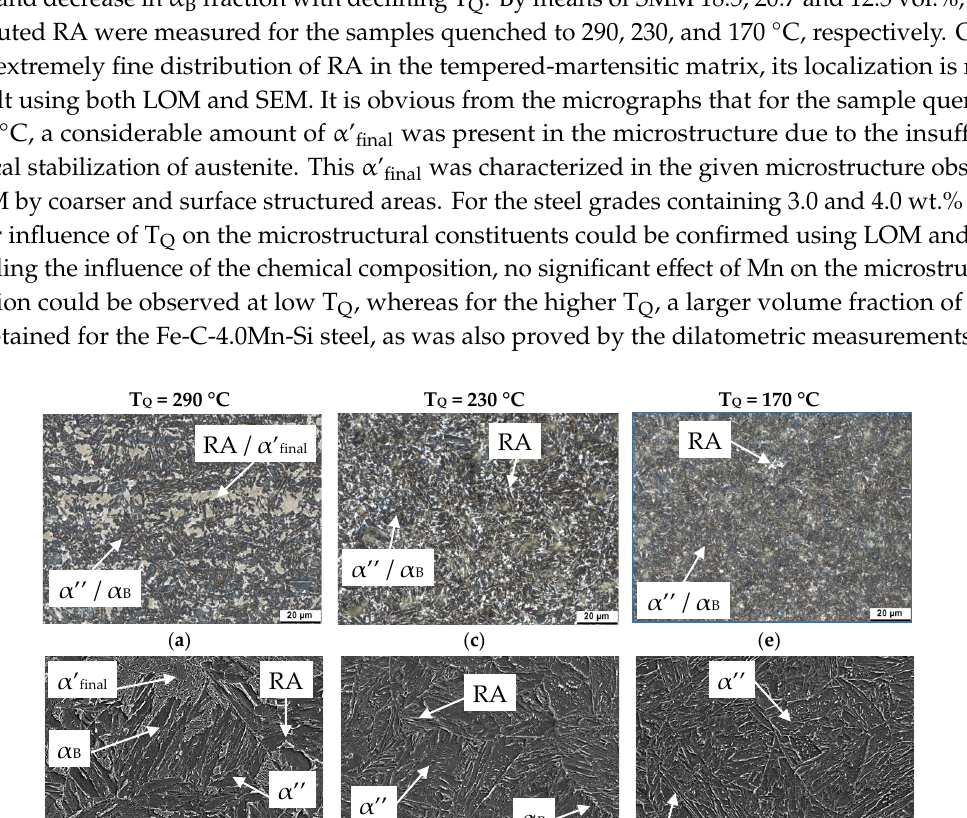
Figure 3. Dilatation due to formation of α B as a function of isothermal holding time for the ( a ) Fe-C-3.0Mn-Si, ( b ) Fe-C-3.5Mn-Si and ( c ) Fe-C-4.0Mn-Si steels quenched to different T Q in order to adjust 50 vol.% (red), 75 vol.% (purple), and 85 vol.% (blue) α ’ prim .